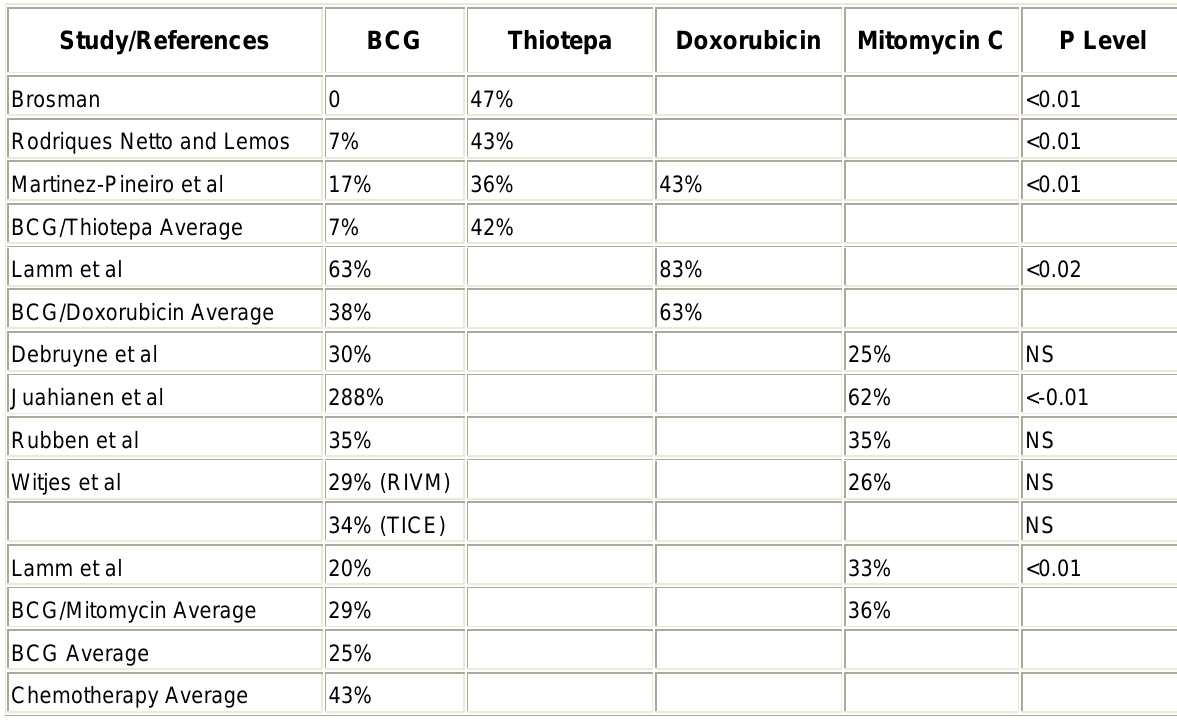
Recurrence in Controlled Comparison